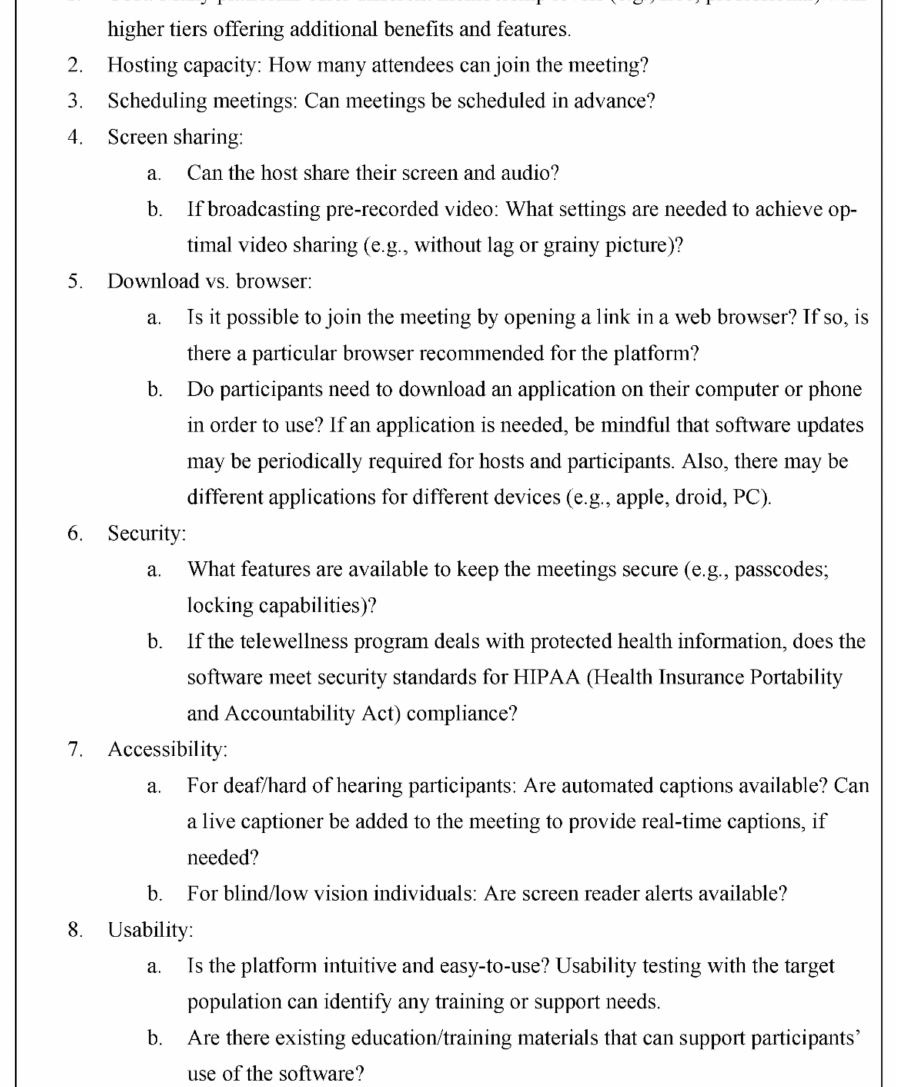
Figure 2. Considerations for Identifying a Software to Deliver Telewellness